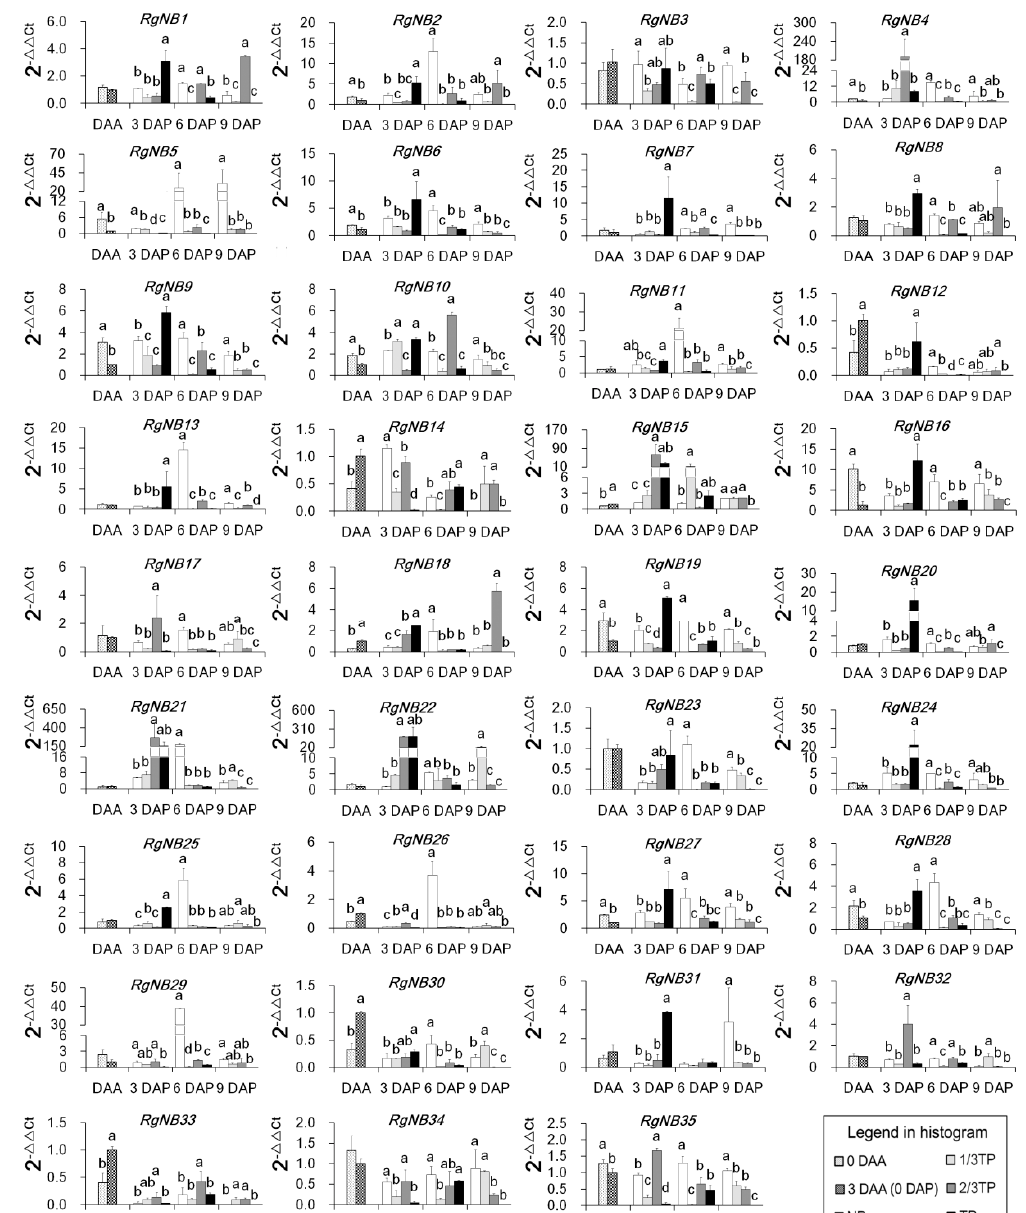
Figure 2. Nucleotide binding-leucine-rich repeats ( NB-LRRs ) expression in R. glutinosa roots during acclimatization and planting phase with di ff erent replant disease stress levels. The ratios of 0 DAA, 3 DAA (0 DAP), NP, 1 / 3TP, 2 / 3TP and TP gradient treatments to 3 DAA (0 DAP) are calculated and shown. Two or four samples in each group are compared with 3 DAA and NP respectively, and di ff erent lower-case letters indicate significant di ff erences ( p < 0.05; LSD). Data represented as the mean ±